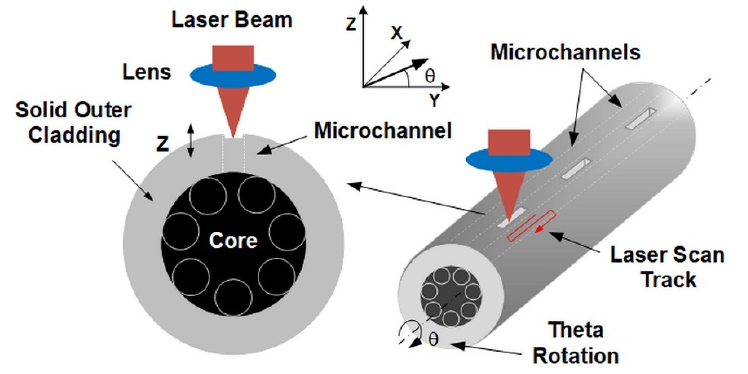
Figure 2. Methods used to process the lateral channels in the outer cladding of the ARHCF.